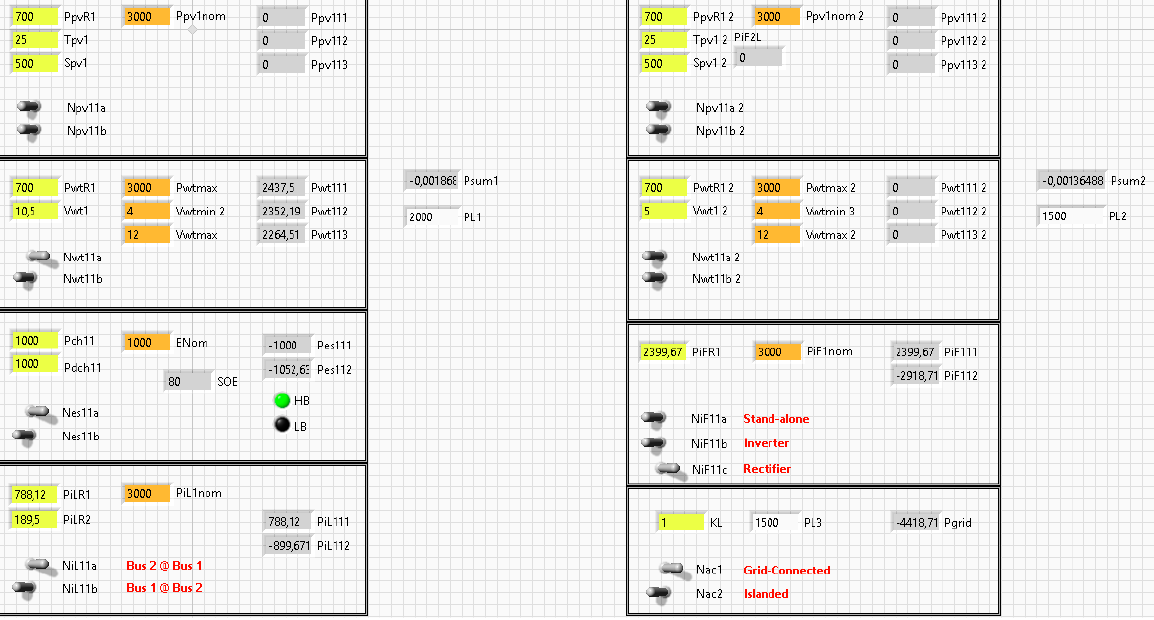
Figure 18. User interface of the simulation implemented in LabVIEW software.